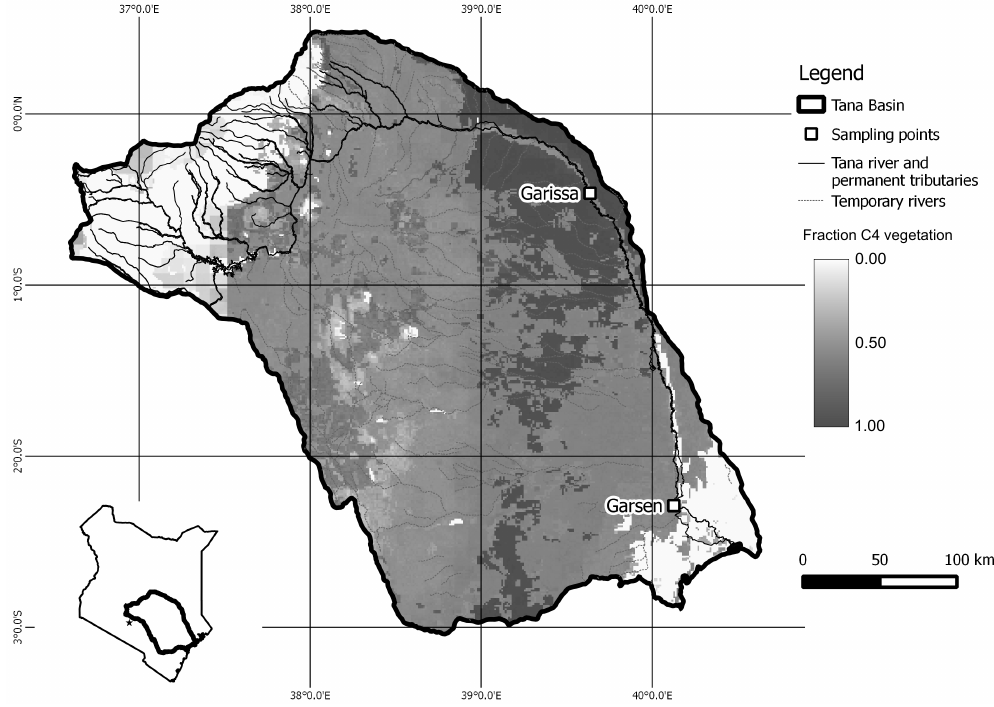
Figure 1. The Tana River with the indication of the two sampling locations in the lower catchment. The shading represents the fraction of C 4 vegetation, based on the isoscapes of Still and Powell (2010). The inset indicates the Tana River basin within